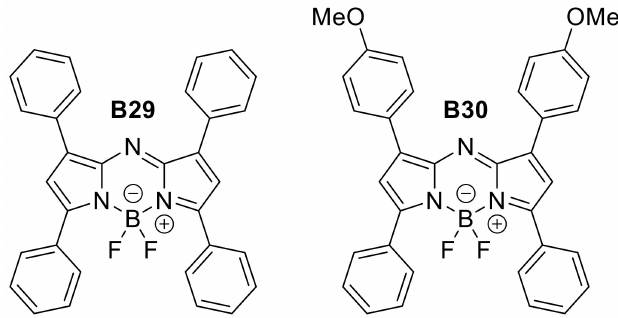
Figure A7. azaBODIPY with substituents at α and β positions.